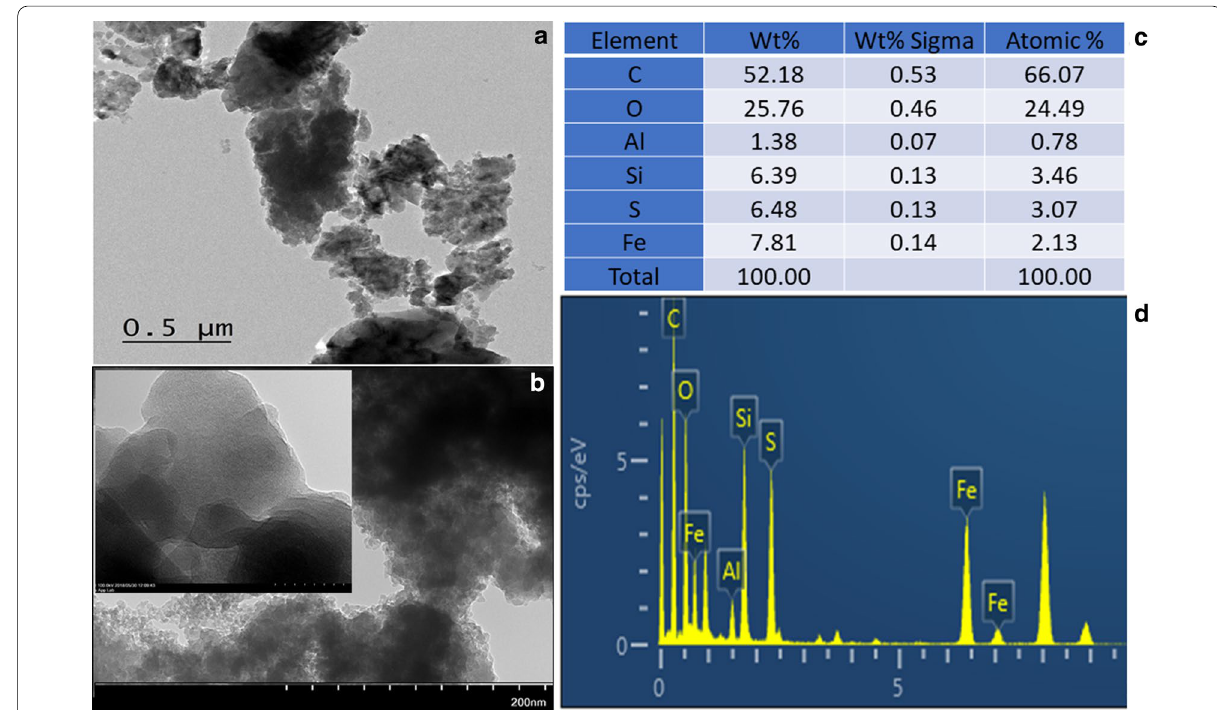
Fig. 2 FETEM images of zeolite-iron at the a 50 nm scale and b 200 nm scale. The nanomaterial was formed with a uniform distribution. c EDX analysis confirming the presence of the main elements Si, Al, Fe, C, and